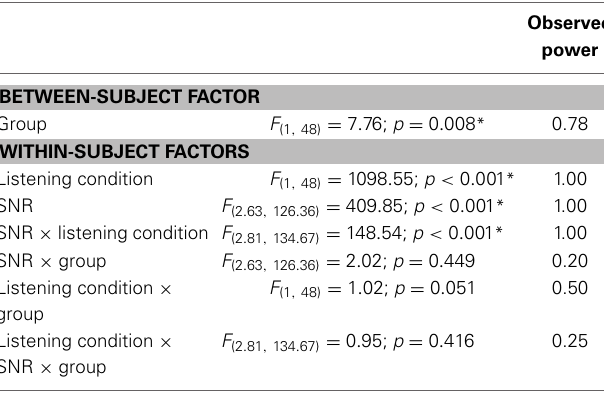
Table 2 | Experiment 1: Results of a split-plot RM ANOVA (with Greenhouse-Geisser correction) for word